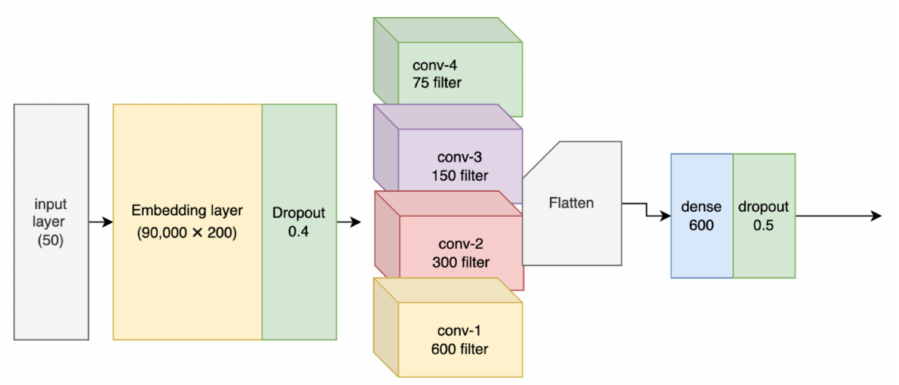
Figure 5. Neural network architecture with four conv.